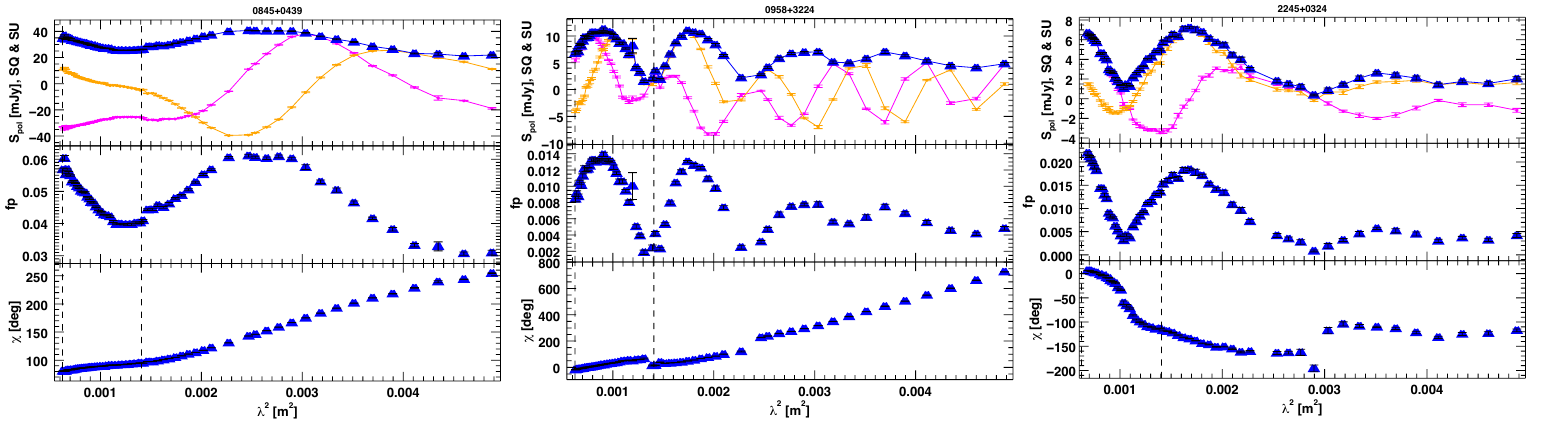
Figure 1. Radio spectra using L, C, and X bands and literature. Total flux density is expressed in (mJy), and the frequency in (GHz). Blue points are the Karl. G. Jansky Very Large Array (JVLA) and literature data and green points are upper limits. Red line is the sum of the different orange synchrotron components.